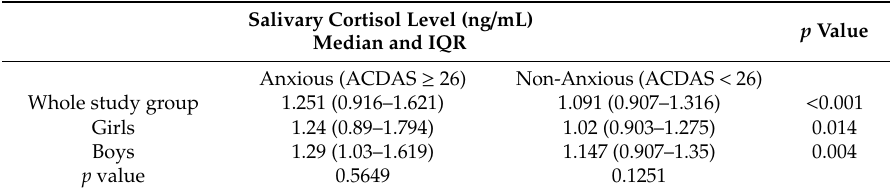
Table 4. Distribution of salivary cortisol levels (ng / mL) within the study group according to gender and anxiety status based on ACDAS score (statistical analysis with a Mann–Whitney